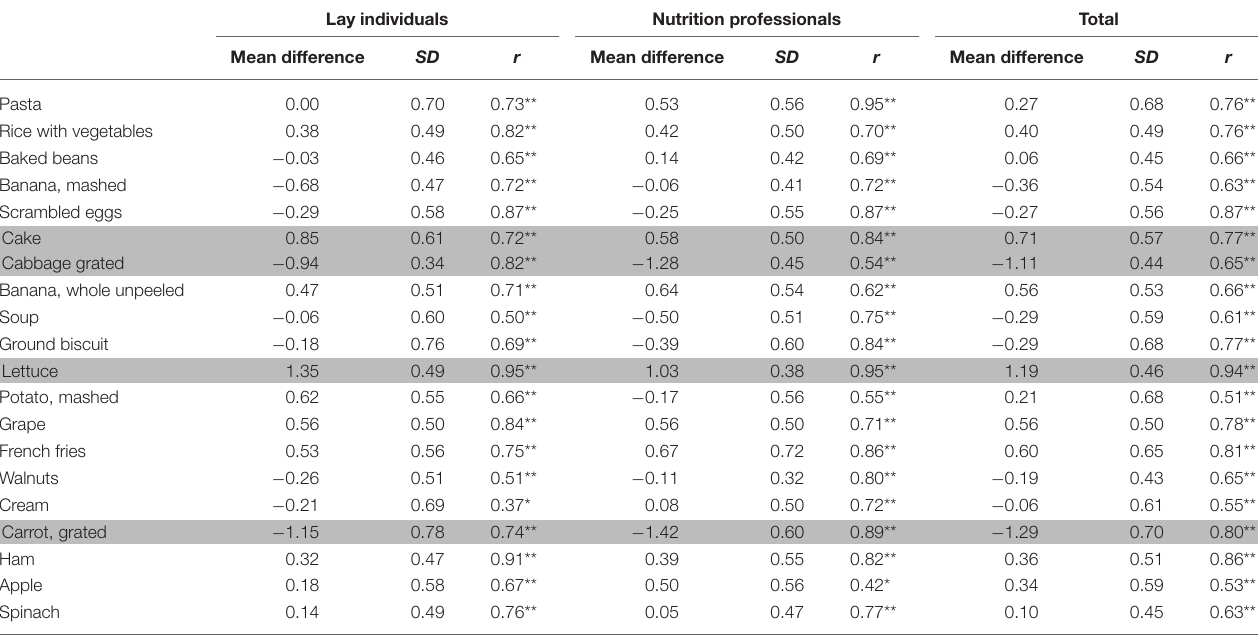
TABLE 2 | List of evaluated foods and recipes with mean and standard deviation (SD) of the difference between the estimated portion number minus the actual portion number; Spearman’s coefficients of correlation ( r ) between the estimated portion number and the actual portion number. Lay individuals Nutrition professionals